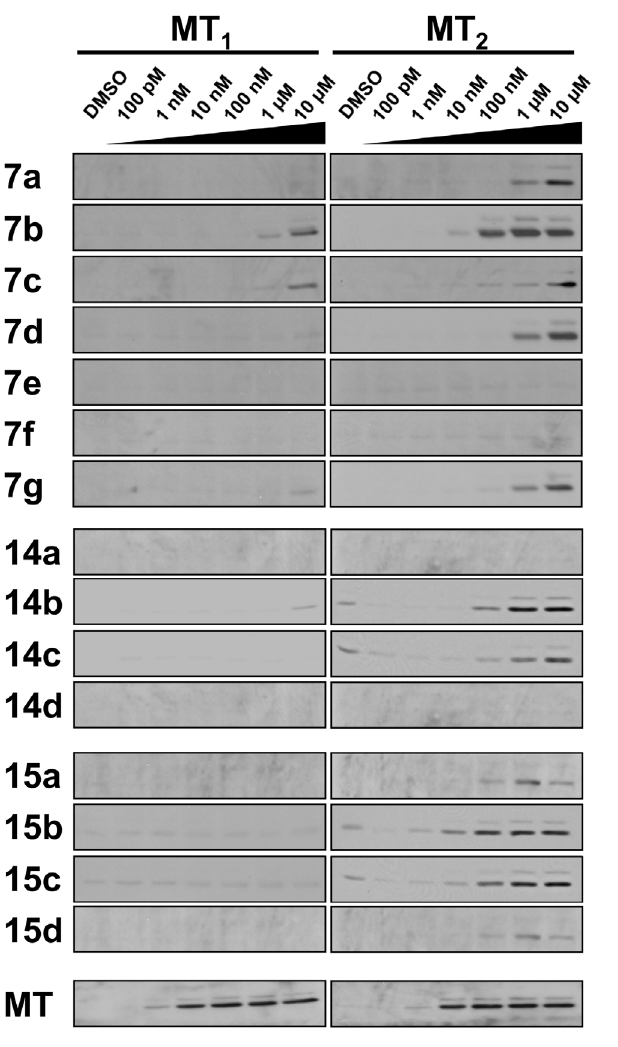
Figure 5. Phosphorylation of ERK induced by isoquinolinone derivatives. CHO cells expressing MT 1 or MT 2 were serum-starved before treating with the indicated concentrations of melatonin or individual tested compounds. Resolved proteins were electrotransferred for immunodetection using phosphorylated ERK- specific antibody. Total amount of ERK was also detected similarly and no observable change of their expression levels has been found for all the treatments (not shown). Three individual trails yielded similar results as the representative blots shown in the